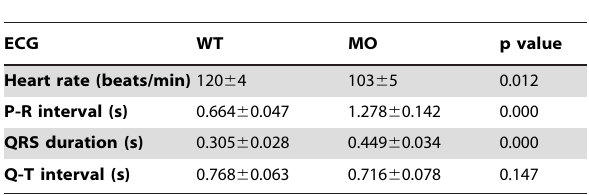
Table 2. Summary of ECG